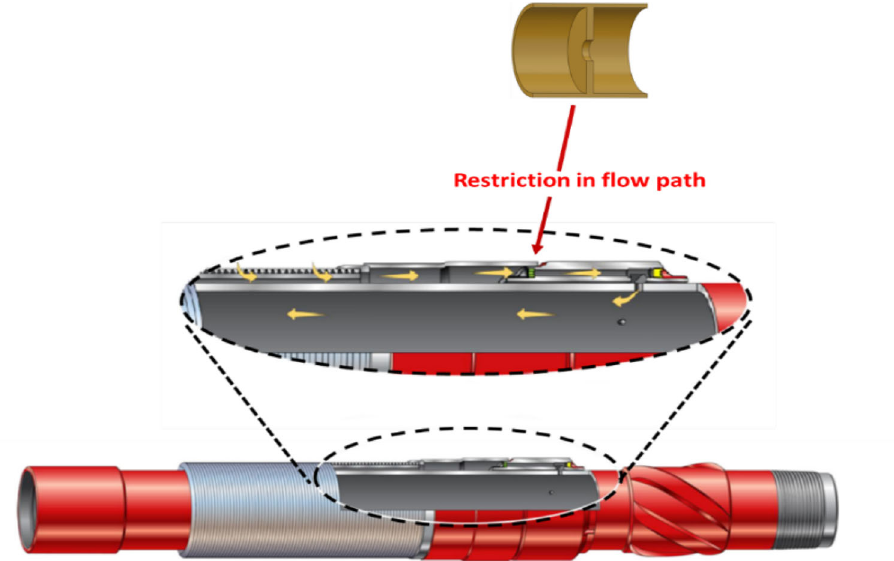
Fig. 2 Expanded view of